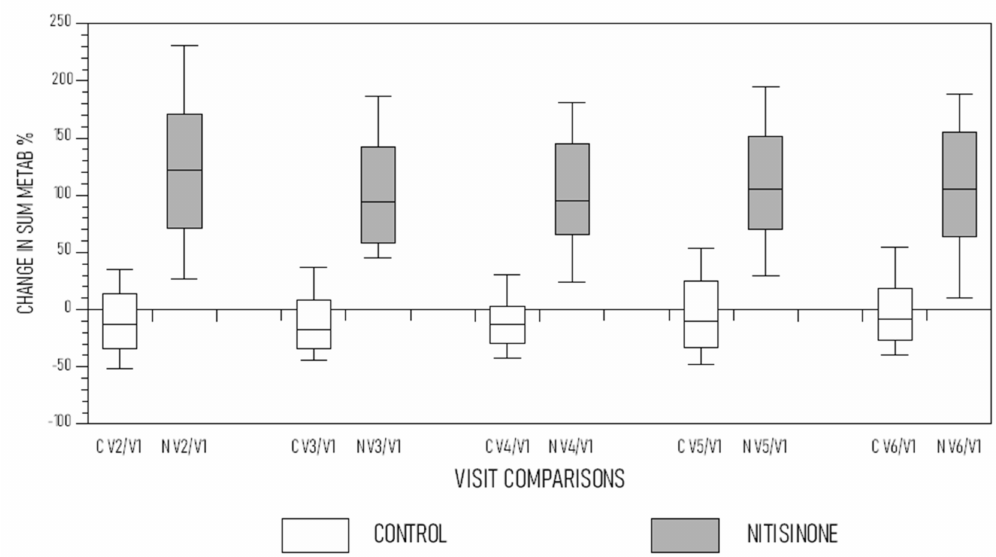
Figure 2. Comparison of change in METAB (%) at V2–V6 compared with V1 ([(V2 − V1/V1) × 100] showing stable mostly neutral values in the control group and significantly higher values in the nitisinone group (C V2/V1 refers to comparison of SUM METAB at V2 vs. V1, and so on for other visits along the X -axis) (data shown as boxplots with